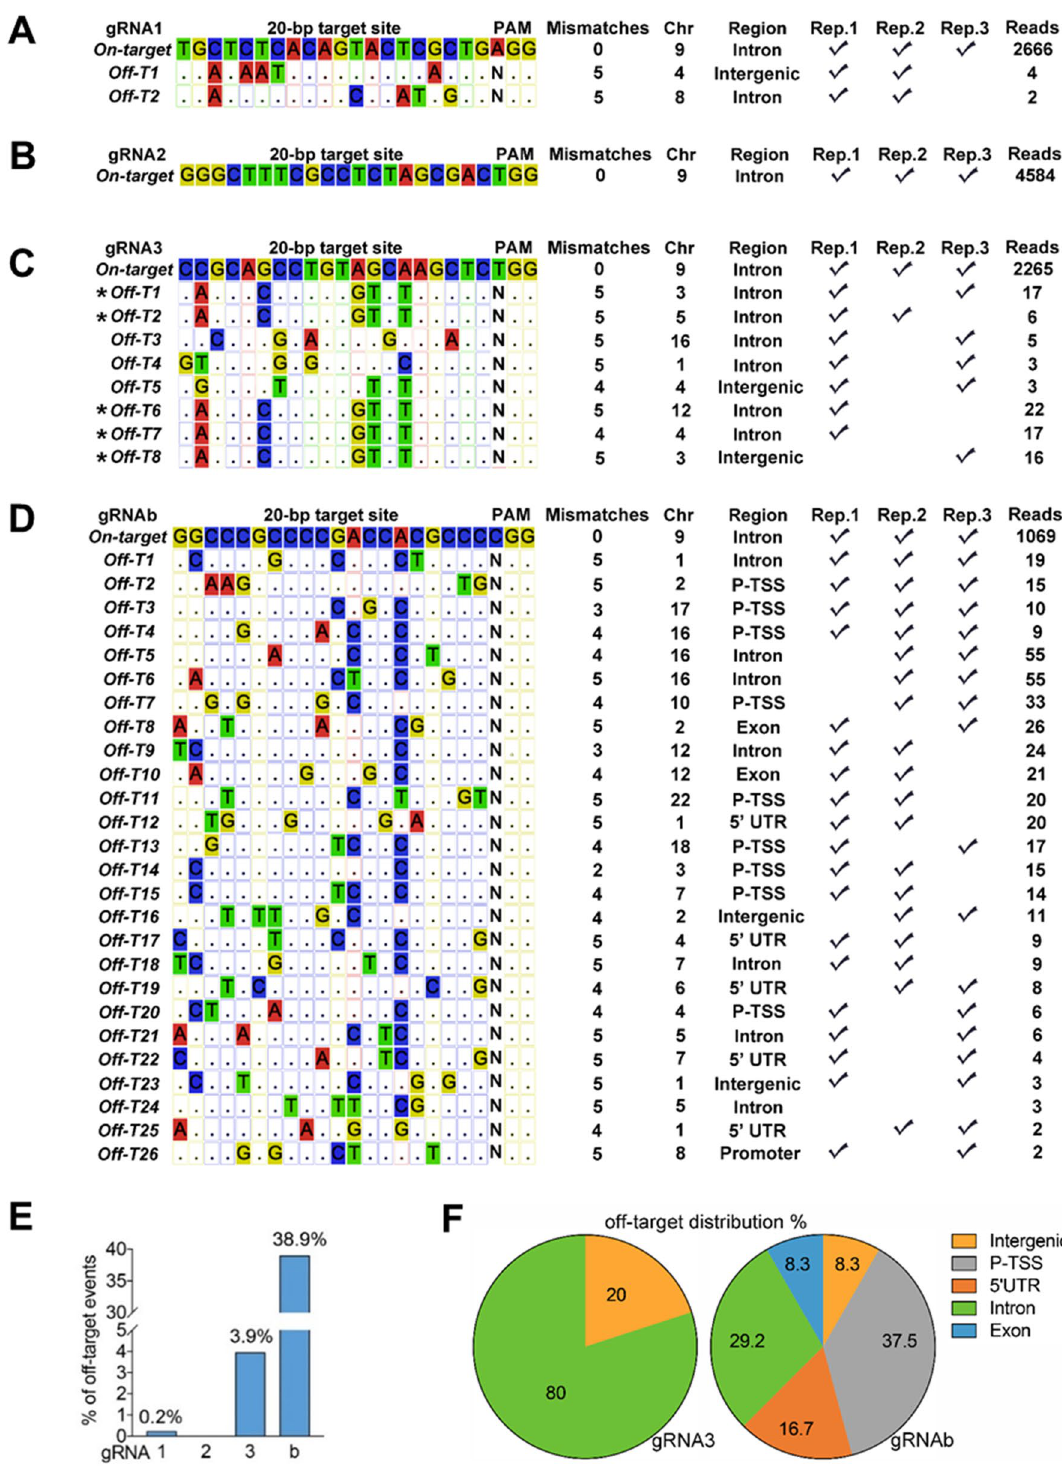
Figure 2. Limited off-target effect of gRNA1-2 measured by GUIDE-seq. ( A - D ) Off-target sites identified by GUIDE-seq. Mismatches are highlighted in colors. In c, asterisks indicate that the same off target sequences in different chromosomes. To increase reliability of off-target events detected by GUIDE-seq, we included the events that were supported by unique reads at different chromosomes or from at least two out of our three independent experiments (Supplementary Fig. 3). ( E ) Off-target percentage was estimated by ratio of off- target reads to on-target reads. ( F ) Off-target site distribution of gRNA3 and gRNAb. In ( A - D) , mismatches in protospacer are no more than 5. P-TSS, region between promoter and TSS (transcription start site). 5’UTR, 5’ untranslated